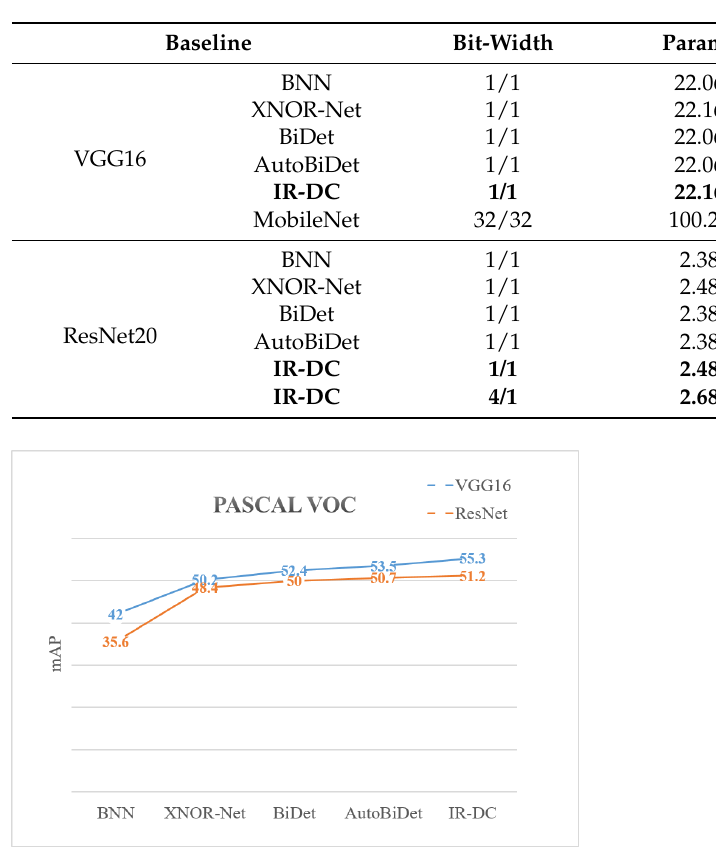
Table 8. Results of PASCAL VOC.